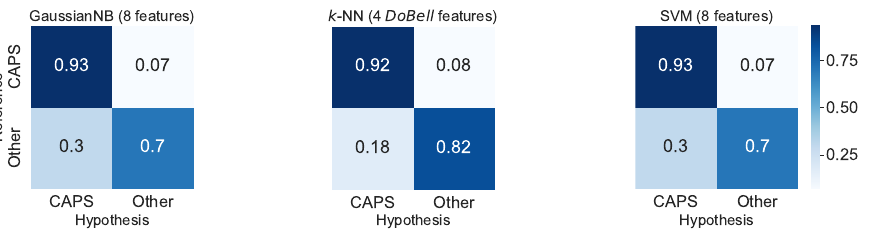
Figure 11. Confusion matrices of the GaussianNB ( left ), the k -NN ( middle ), and the SVM ( right ) classifiers accumulating ten-fold results with the local best feature combinations. CAPS: traditional Chinese folk songs in the Chinese Anhemitonic Pentatonic